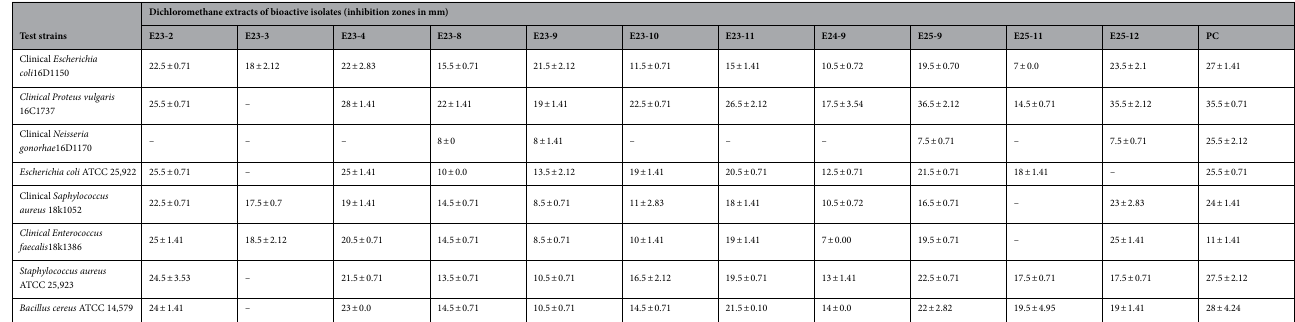
Table 3. Secondary screening (antibacterial activity) by disc diffusion method. (–) no inhibition zone, PC positive control (Streptomycine) and disc diameter = 6